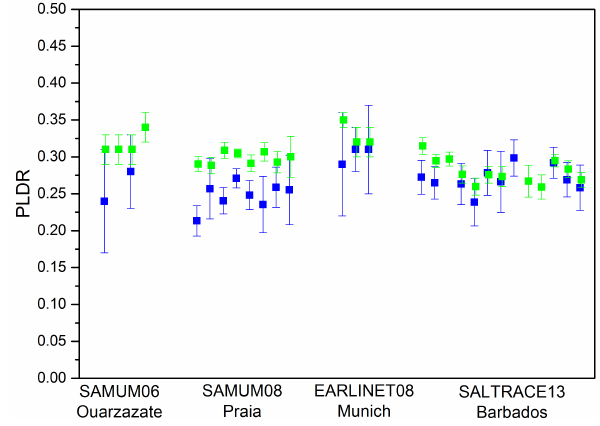
Figure 12. Mean values of the particle linear depolarization ratio of Saharan dust at 355nm (blue) and 532nm (green) derived for fresh Saharan dust on 4 days during SAMUM-1 in Ouarzazate, Morocco, in 2006 (SAMUM06) (Freudenthaler et al., 2009); for mid-range transported Saharan dust on 8 days during SAMUM-2 in Cape Verde in 2008 (SAMUM08) (Groß et al., 2011b); for long- range transported dust over Central Europe on 3 days in Munich, Germany, in 2008 (EARLINET08) (Wiegner et al., 2011); and for long-range transported Saharan dust over the Caribbean on 13 days during SALTRACE in Barbados in 2013 (SALTRACE13). The er- ror bars denote the systematic